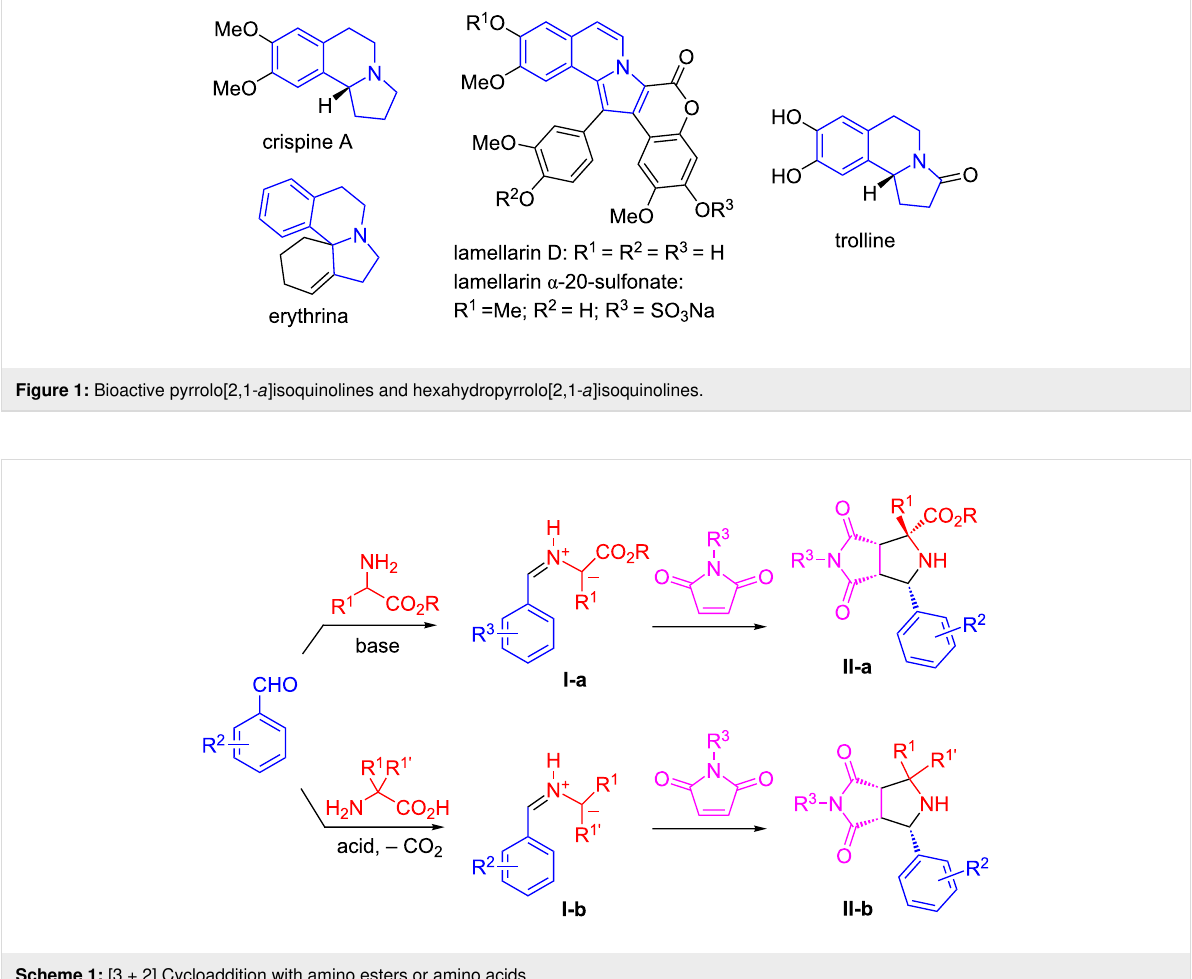
Scheme 1: [3 + 2] Cycloaddition with amino esters or amino